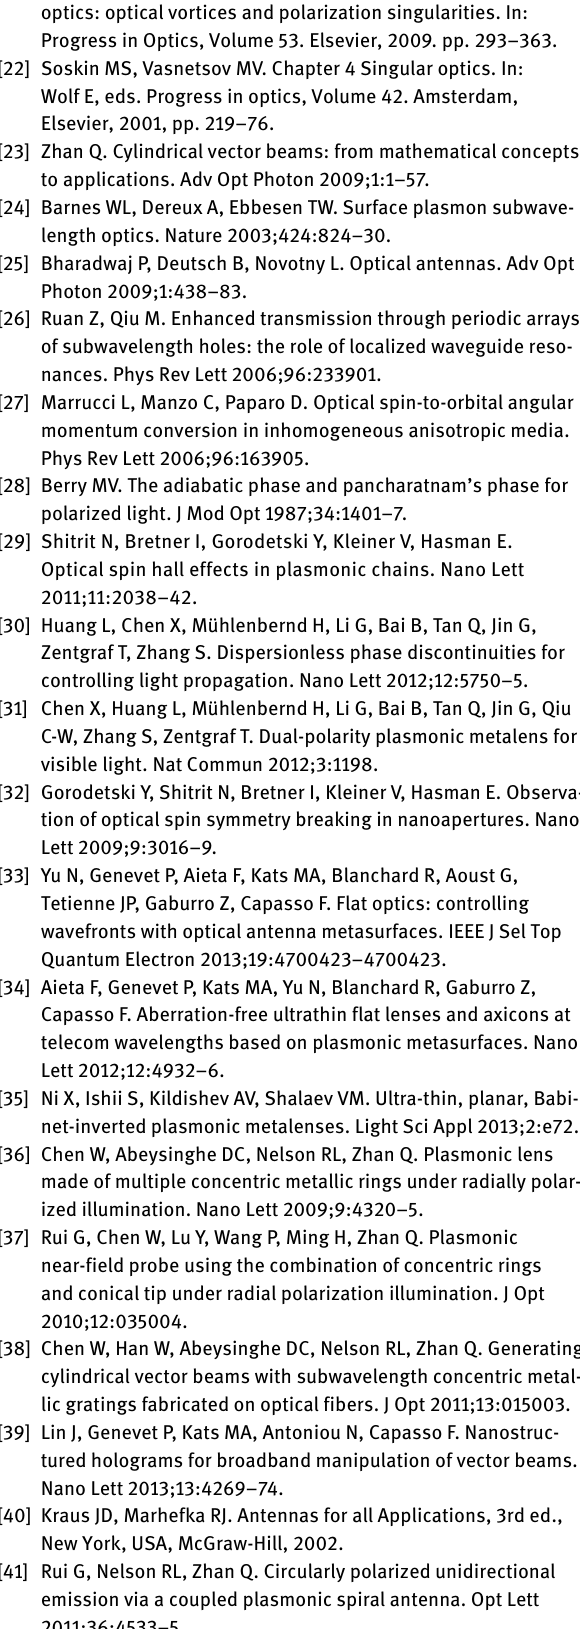
figurable beams with arbitrary polarization and shape